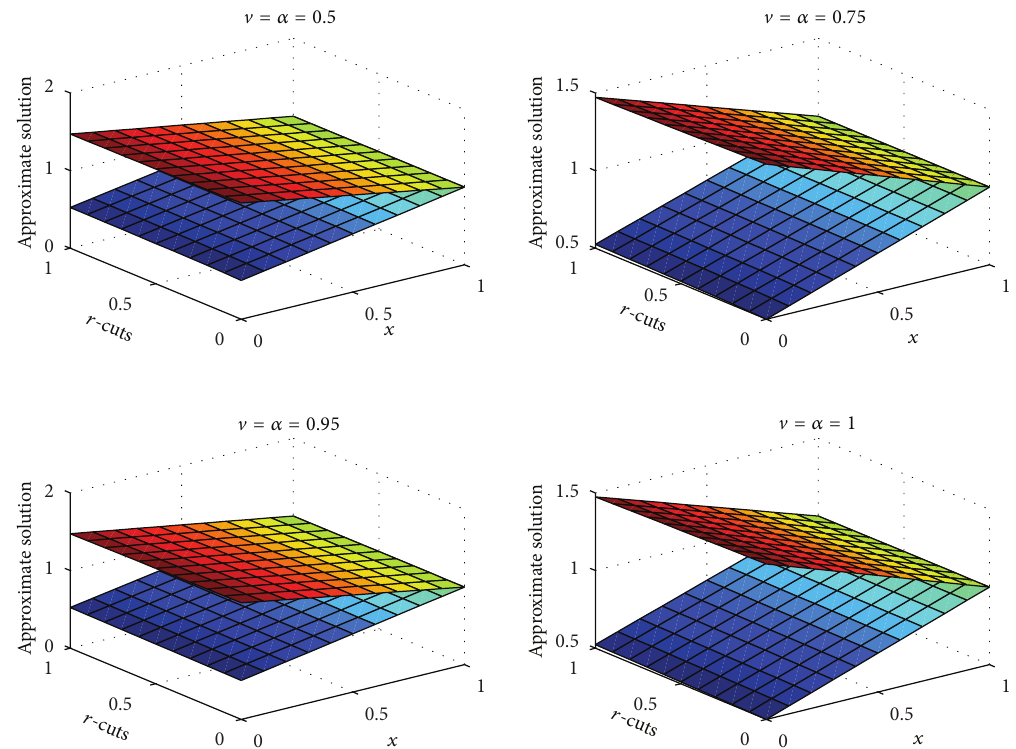
Figure 15: The fuzzy approximate solution for different values of fractional orders V = 𝛼 with 𝑚 = 10 , 𝑘 1 = 0.05 , and 𝑘 2 = 0.05 .